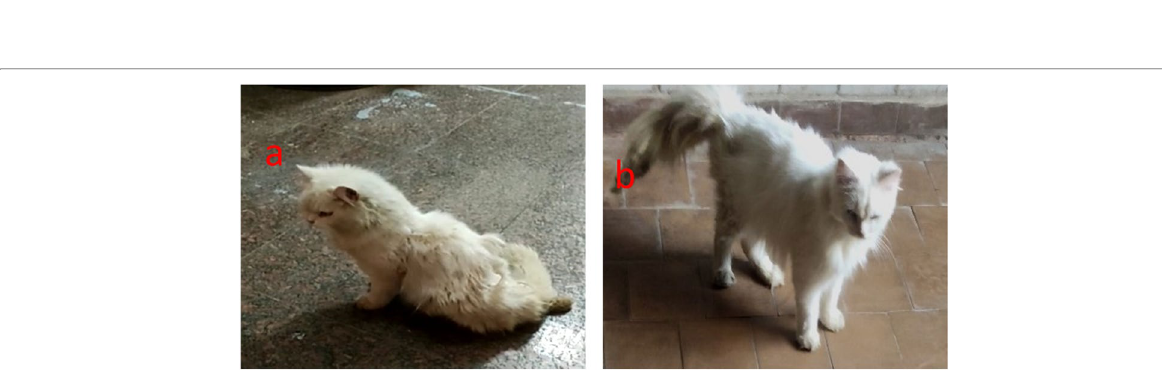
Fig. 3 The effect of treatment on motor function in PRP co-treated group. A After induction of injury. B After receiving PRP as